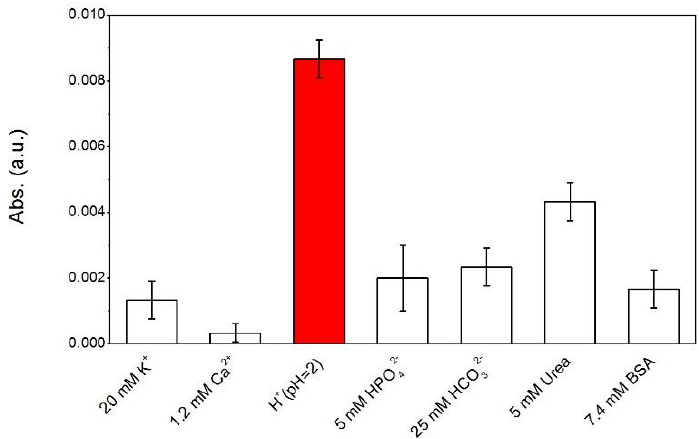
Figure 7. The responses of PANI-GNPs-glass to the main components in saliva, including some electrolytes, proteins, and small organic molecules at 785 nm. The concentrations of electrolytes and proteins that we used here were the typical level of the concentration of all the components in real saliva. Abs was used to represent the response of the sensor to a component in saliva ( Abs = |Abs c - Abs 0 |, Abs 0 is the absorbance of the sensor in PBS (pH = 7.4); Abs c is the absorbance of the sensor in PBS mixed with some main component in saliva). The error bars represent ±1 standard deviation of the mean for three different measurements. PBS: phosphate buffer solution; BSA: bovine serum albumin.